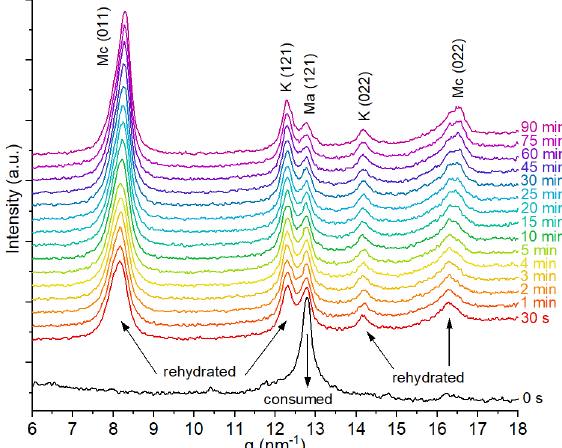
Figure 4. WAXS patterns of the rehydration of calcined calcium aluminate at room temperature. Denoted are Mc (monocarboaluminate), K (katoite), and Ma (mayenite).